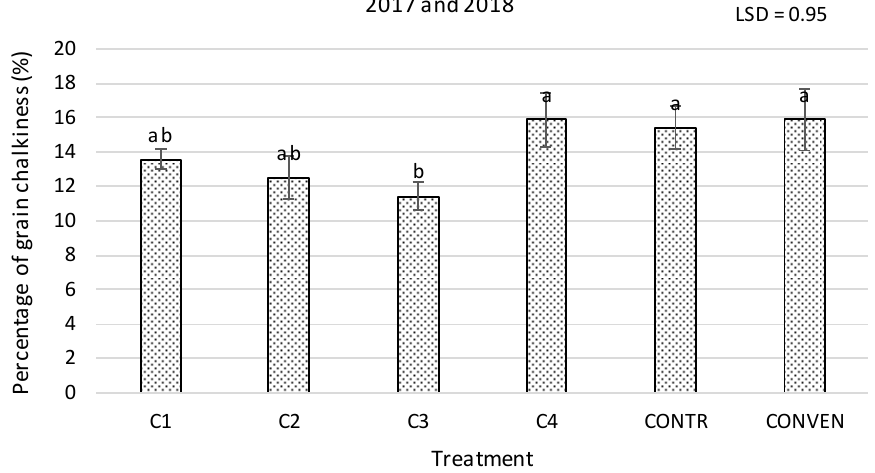
Figure 12. The percentage of grains with chalkiness (means ± se) of grains harvested of rice plants grown in differently fertilized soil of the experiments during 2017 and 2018. Treatments contain compost application of (i) 80 kg ha − 1 N in split application (C1), (ii) 160 kg ha − 1 N in split application (C2), (iii) 320 kg ha − 1 N in split application (C3), (iv) 160 kg ha − 1 N in single application (C4), (v) an untreated control (CONTR), and (vi) 160 kg ha − 1 nitrogen chemical fertilizer (CONVEN). Means were compared by the Bonferroni adjusted LSD value at p < 0.05. Different letters characterize significant differences between treatments for each parameter. Full description of the treatments examined is